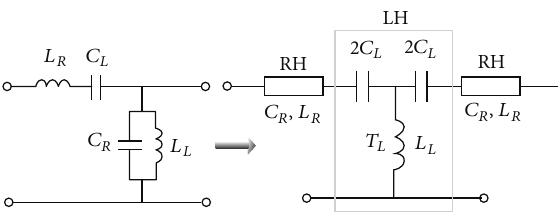
F 1: Electronic emulation of metamaterial properties and its equivalent circuit.